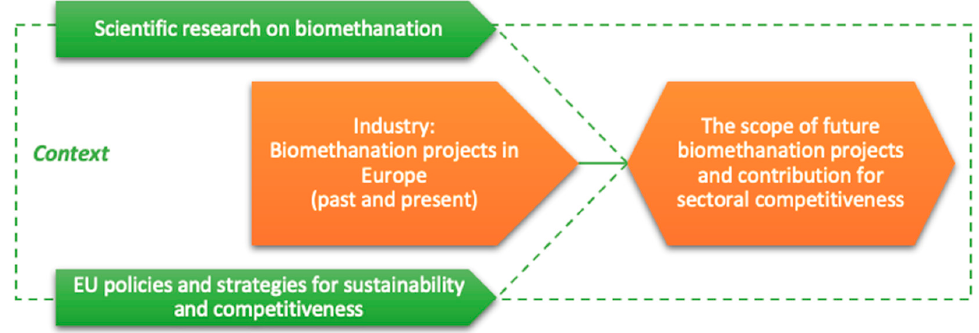
Figure 2. Research framework (Orange: Focus of the research; Green: Context of the research).